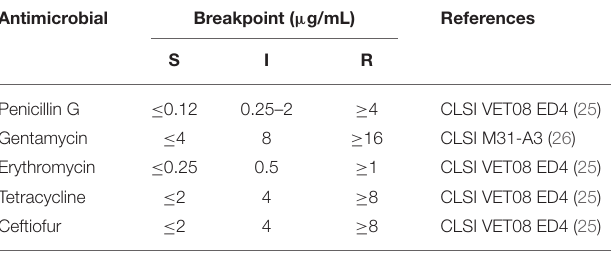
TABLE 2 | Antimicrobial susceptibility breakpoints used to determine the antimicrobial susceptibility (S), intermediate (I), and resistance (R) of Streptococcus uberis .